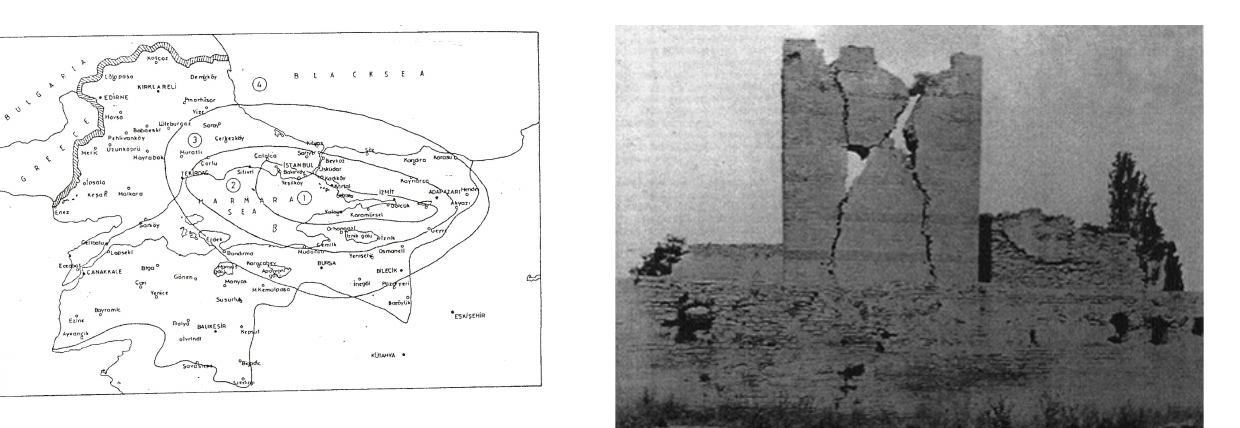
Fig. 4. A photograph of the damage to the towers in Topkapi following the 1894 earthquake in Istanbul (http://www.tarihimiz.net/v3/haberler/genel/tarihte-istanbul- depremleri.html).